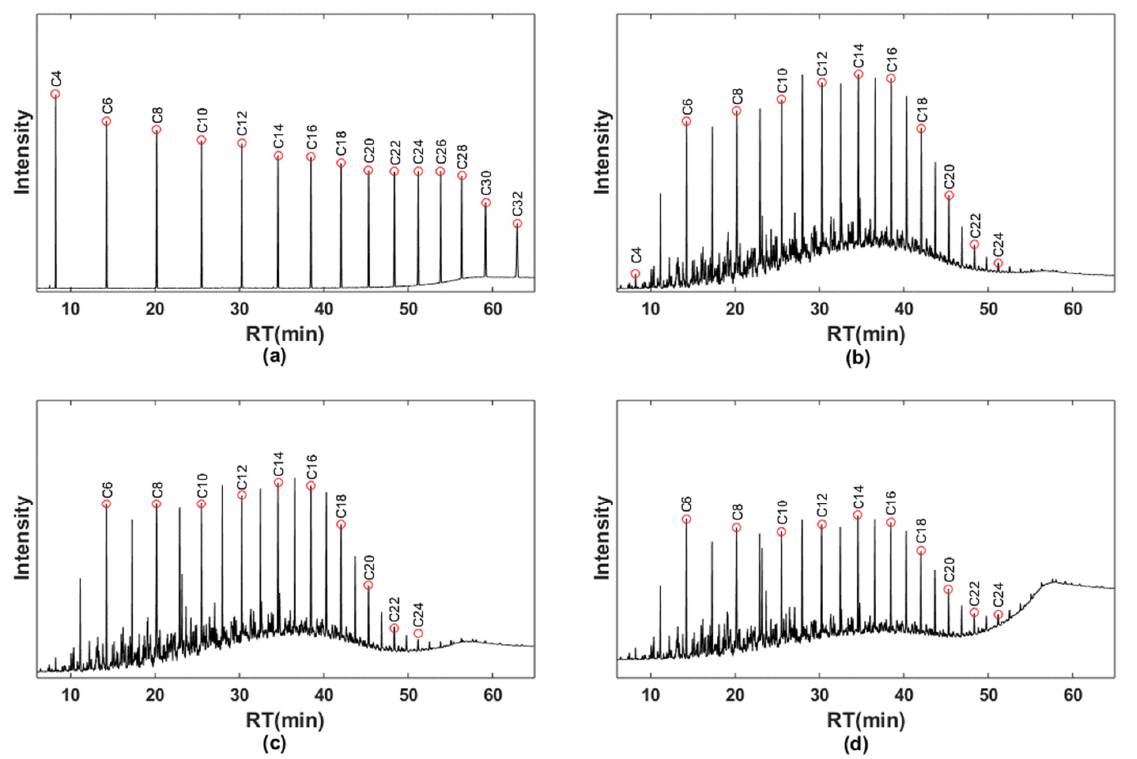
Figure 3. GC/FID profiles before ultrasonic irradiation: ( a ) TPH; ( b ) BFO1; ( c ) BFO2; ( d )